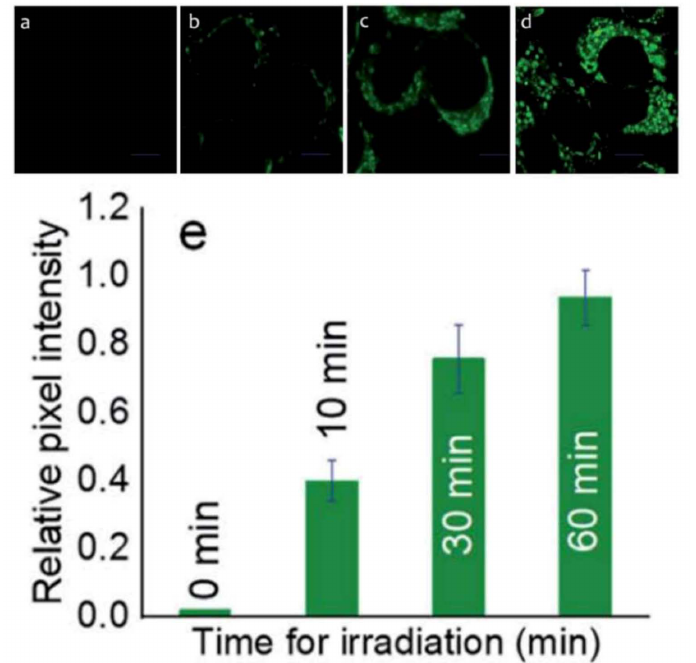
Figure 8. Cellular fluorescence images of prodrug 33 treated MCF-7 cells. The cells were incubated with 33 (1 mM) for 2 h and then irradiated with a blue LED for: ( a ) 0 min, ( b ) 10 min, ( c ) 30 min, and ( d ) 60 min. ( e ) Relative pixel intensity ( n = 3) from the images. The pixel intensity from the images. The pixel of ( d ) is defined as 1.0. Scale bar 10 µ m. λ ex 650 nm; λ Mon window of 530–710 nm. Adapted from